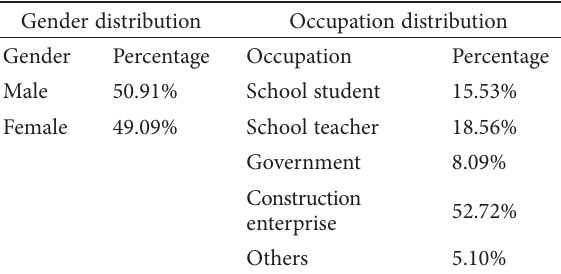
Table 1. Characteristics of respondents ( N =